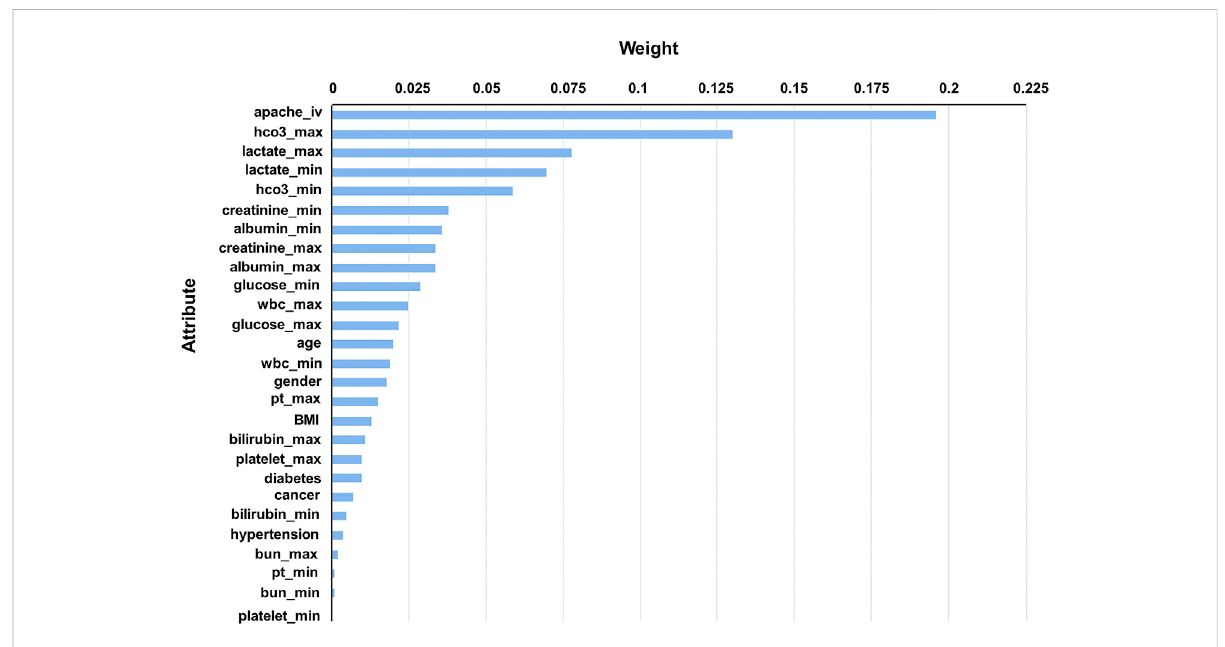
FIGURE 2 Feature screening of sepsis-associated ARDS diagnostic